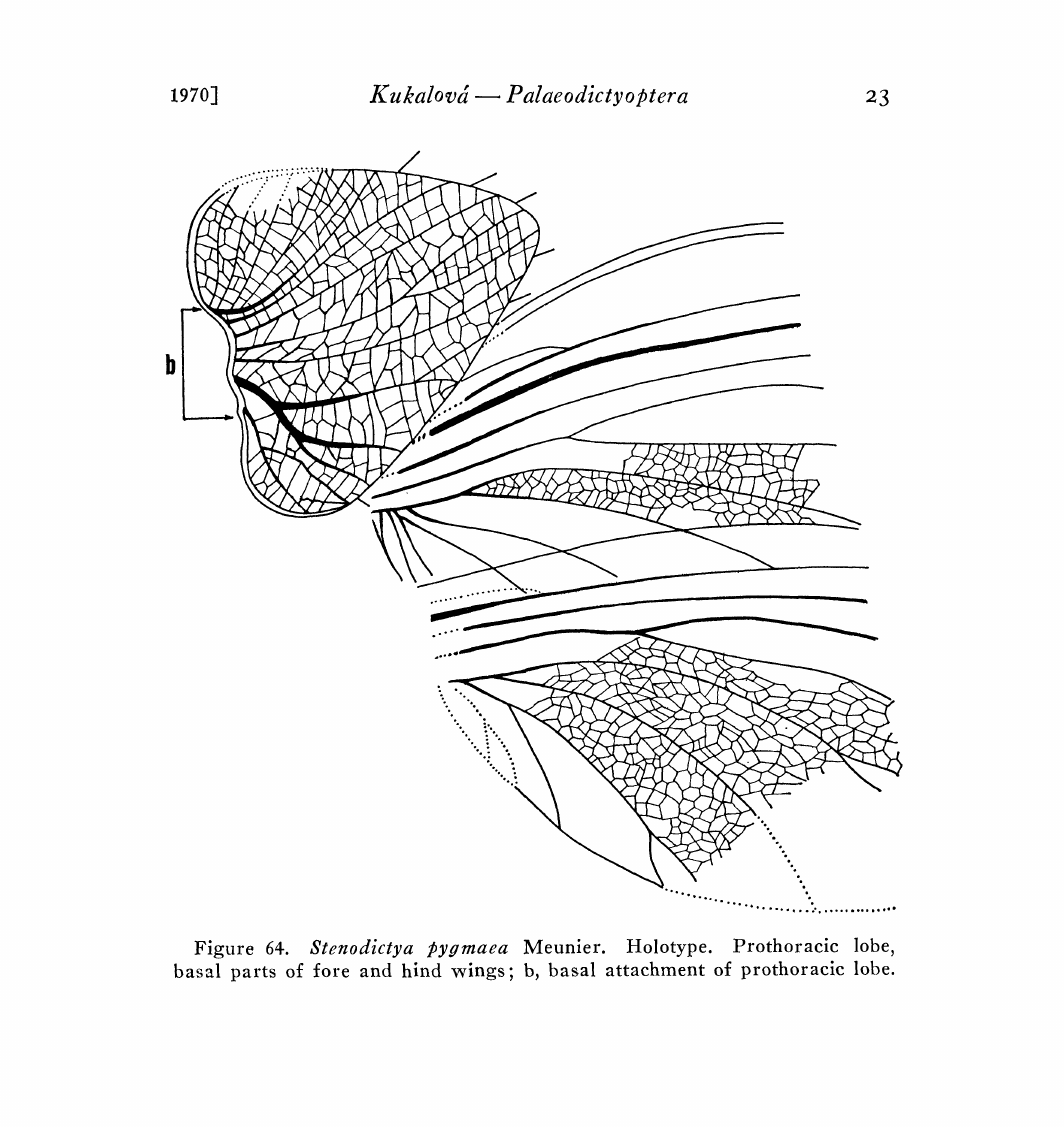
Figure 64. Stenodictya pytmaea Meunier. Holotype. Prothoracic lobe, basal parts of fore and hind wings; b, basal attachment of prothoracic